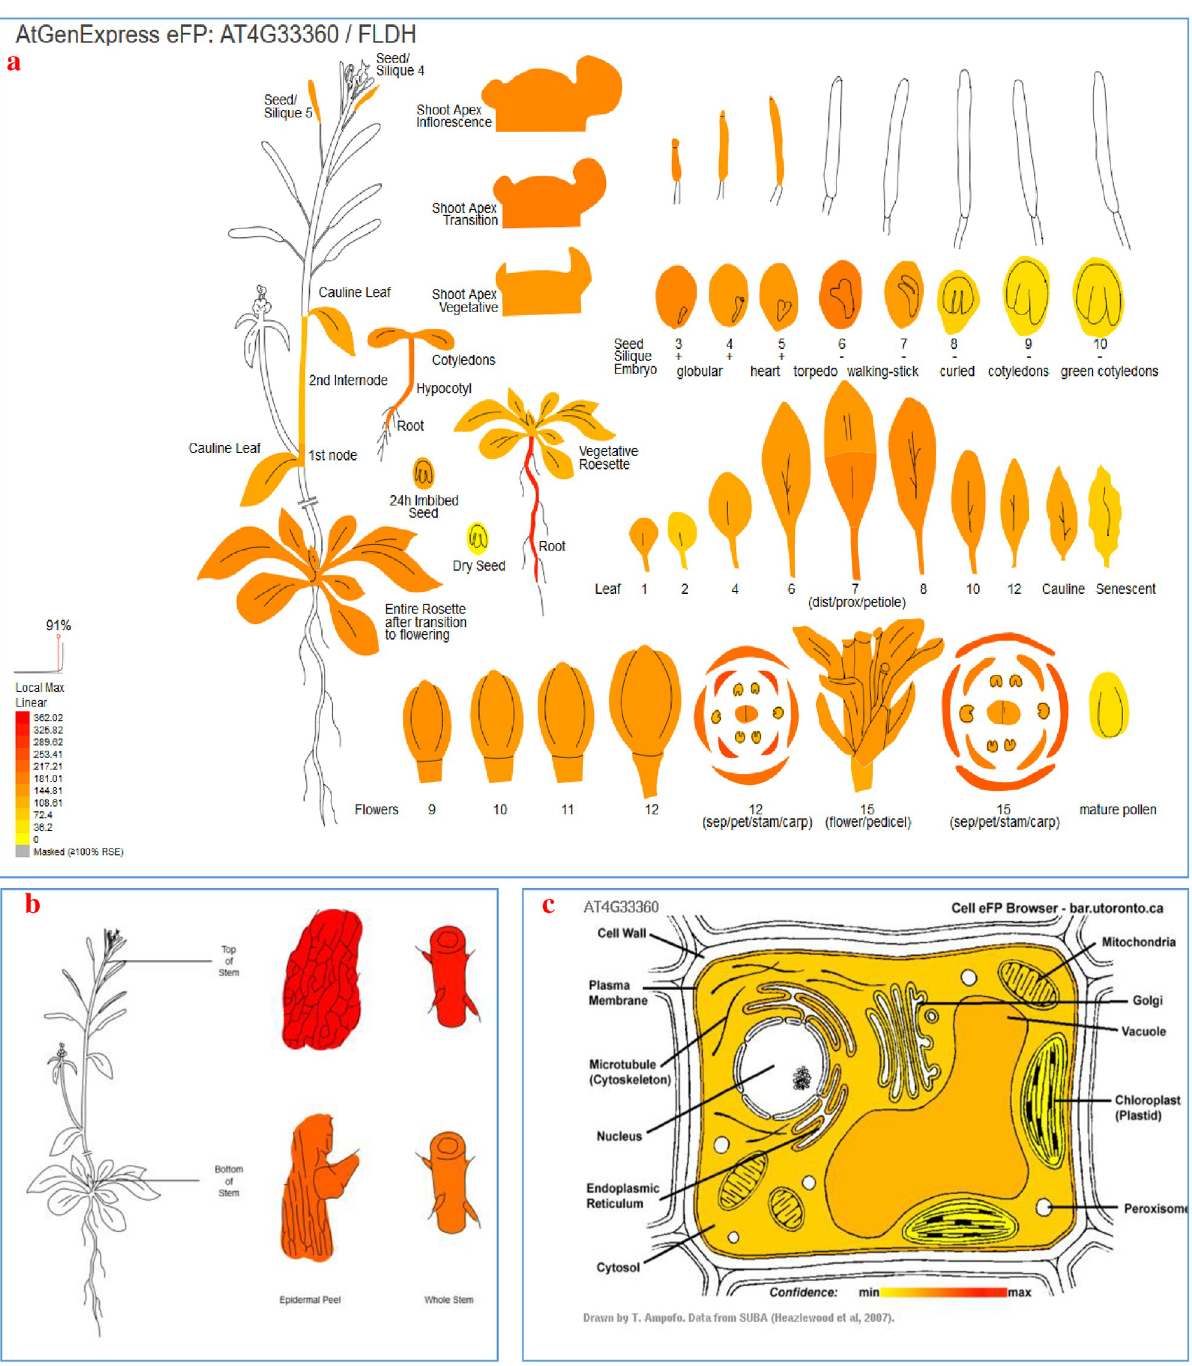
Fig 3. Visualization the putative an “electronic fluorescent pictograph” browsers for exploring the putative tissue expression and cell localization of SoFLDH (AT4G33360) gene, based on Arabidopsis gene expression and protein localization at different tissues and cell organs. a Expression data at different tissues from seedling to flowering stages. b Expression data of tissue specific stem epidermis at top and bottom. c Expression data at different cell organs. The blue arrow points the expression scale (the more intense red color, the more gene expression).